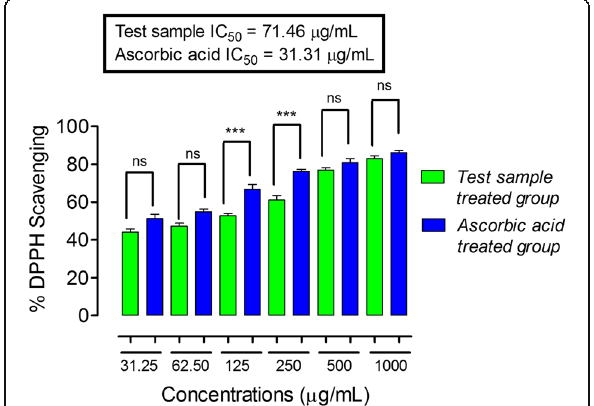
Fig. 3 Results of antioxidant potentials of Olax nana using DPPH assay. Values significantly different in comparison to the positive control (ascorbic acid) and test samples at the same concentration at 95% confidence interval. *** P < 0.001, ns: values not significantly different in comparison to % inhibition of the positive control ( P >0.05) at the same concentration. One-way ANOVA followed by Bonferroni ’ s